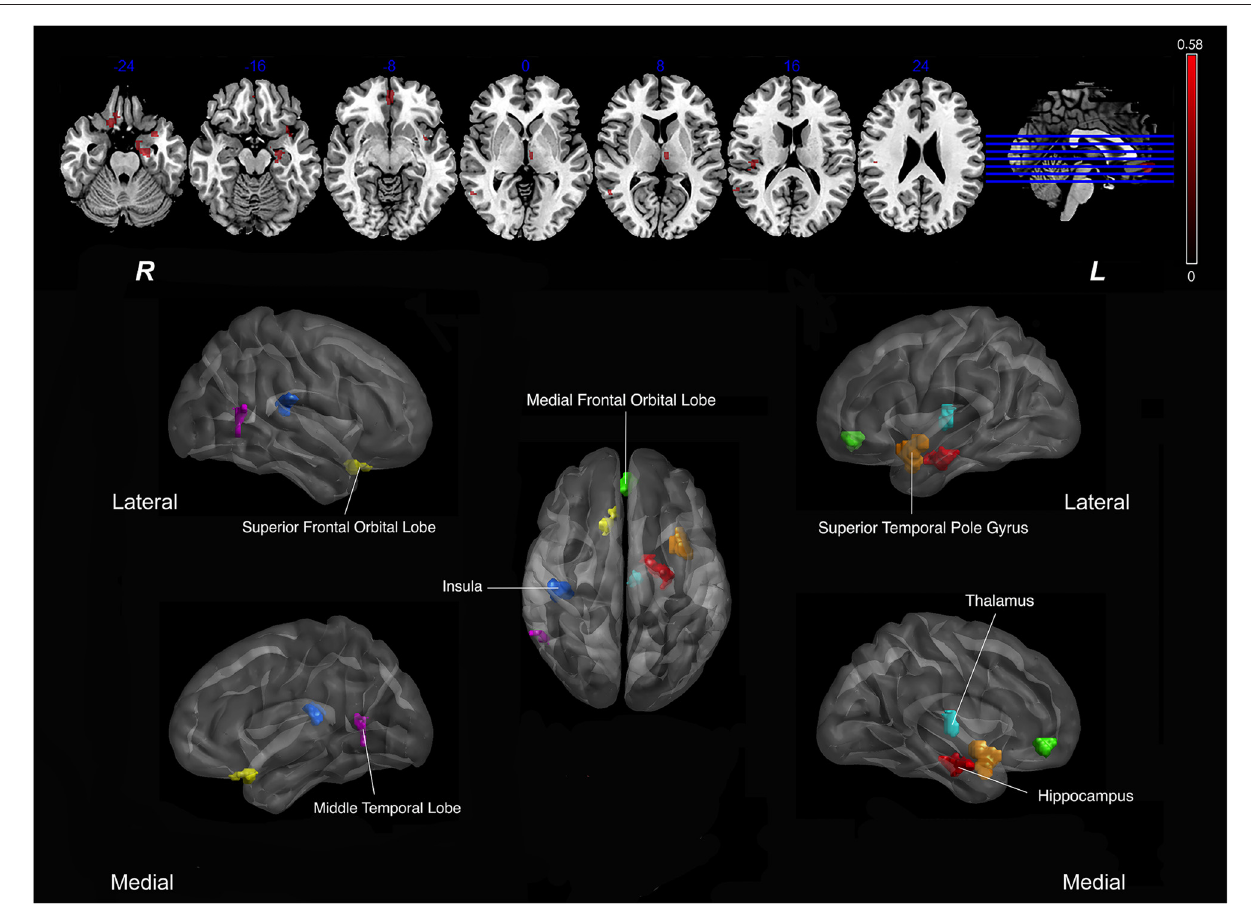
FIGURE 2 | Correlation between Regional CBF (rCBF) values and z scores in subjects with SVCI. Significant positive correlations were found in the mean nsCBFcorrect values with the z -scores in SVCI group ( p < 0.05, AlphaSim-corrected). Red indicates positive correlation. In the lower part of the picture, colors represent areas of the brain: red, represents the left hippocampus; orange, left superior temporal pole gyrus; yellow, right superior frontal orbital lobe; green, right medial frontal orbital lobe; dark blue, right insula; pink, right middle temporal lobe; light blue, left thalamus. Note: The left part of the figure (L) represents the participant’s left side, (R) represents the participant’s right side. SVCI, subcortical vascular cognitive impairment; CBF, cerebral blood